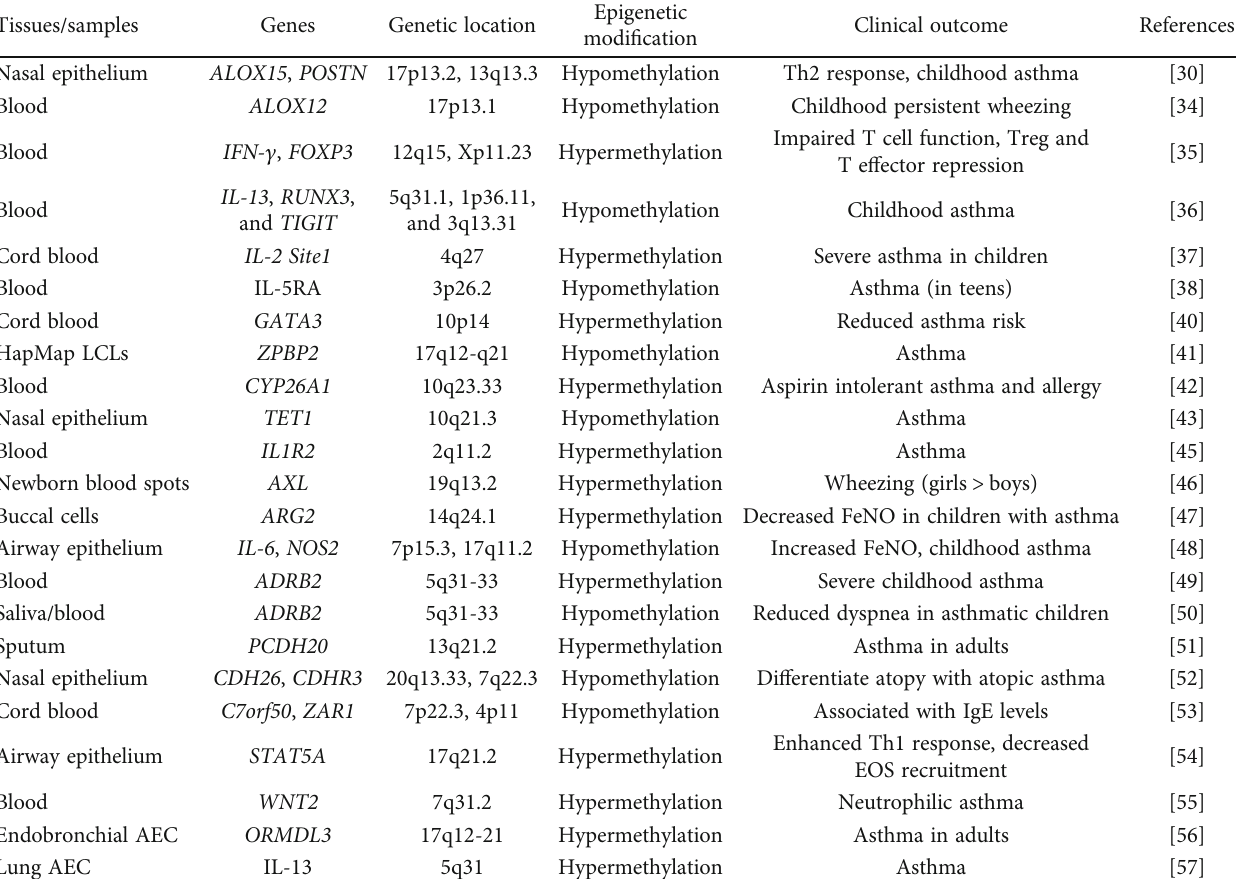
Table 1: Some DNA methylated genes with genetic loci, epigenetic modi fi cations, and clinical outcome from di ff erent tissues/samples.